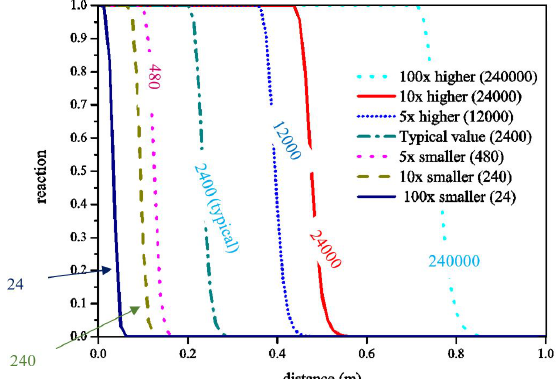
Figure 4. Parametric analyses, results for reaction field - Initial CO 2 diffusivity (values in mm 2 /day) - 50 years - Given the symmetry, in this figure only half of the profile is